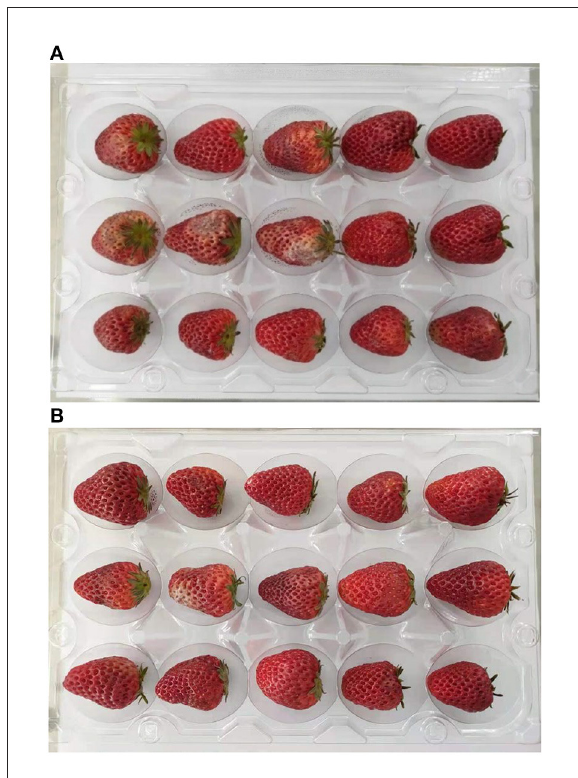
FIGURE1 Appearance of the control (A) and ultrasound (B) groups at 24 d, ultrasound treatment condition was frequency 28kHz, power 0.15 W/cm 2 , time 3min.